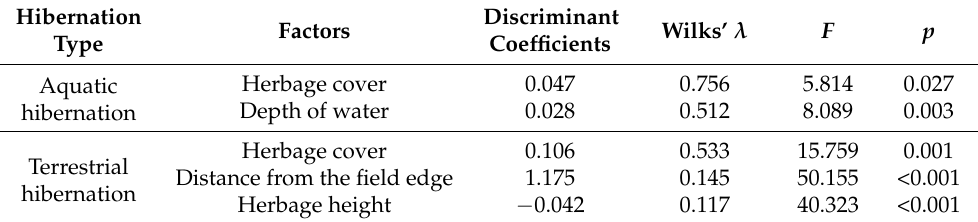
Table 3. Stepwise discriminant analysis between selected and random habitats in hibernating Reeves’ turtles in Qichun County, Hubei Province,